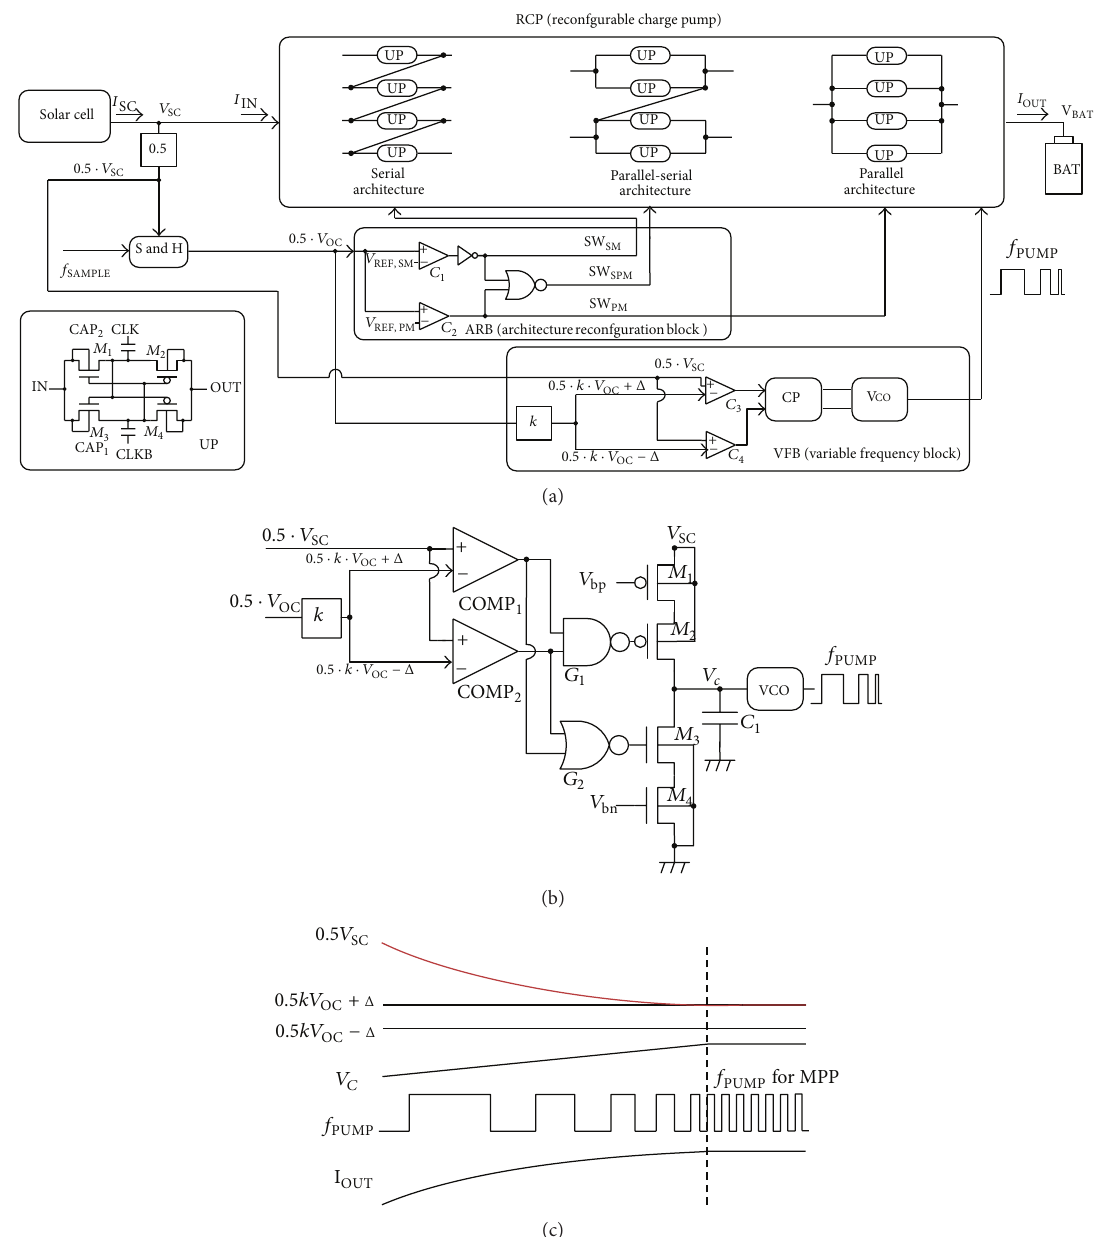
Figure 6: (a) Block diagram of the new RCP circuit that is proposed in this paper. (b) Circuit schematic of the VFB. (c) Voltage and current waveforms of the